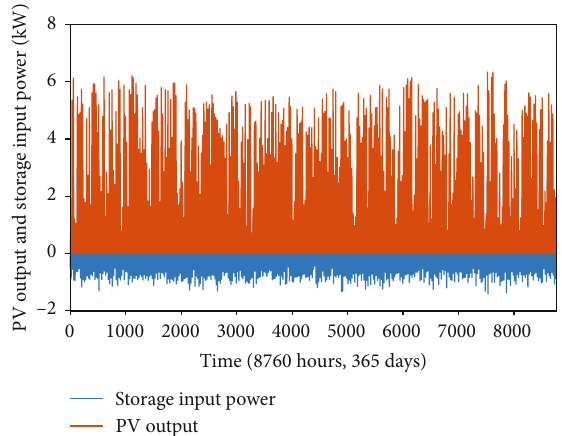
Figure 10: Annual PV output and input storage power for the stand-alone PV